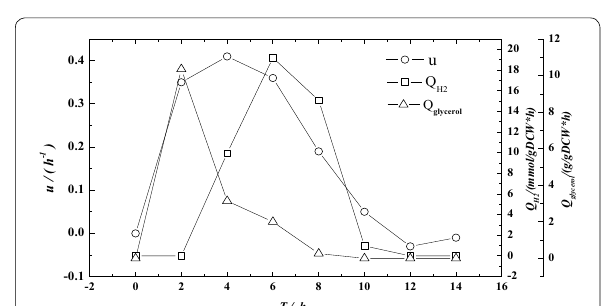
Fig. 5 The changing trend of μ , Q glycerol , and Q H2 during EB-06 biohydrogen production process